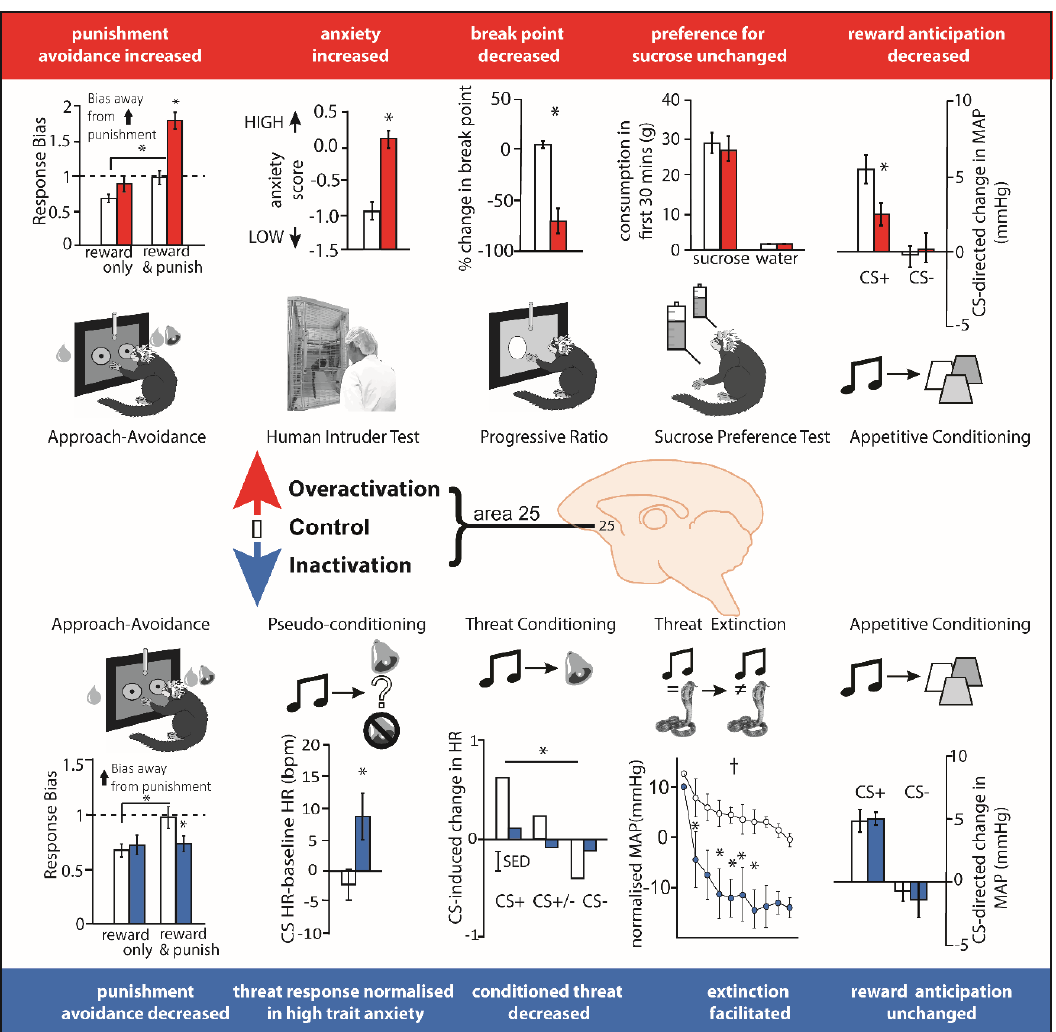
Figure 3. Over-activation and inactivation of area 25 in marmoset has largely opposing effects on tests measuring the regulation of responsivity to rewarding and punishing stimuli. Top from left. Over-activation via presynaptic glutamatergic disinhibition increased the bias away from punishment in an approach-avoidance decision making paradigm [140], and over-activation via inhibition of the excitatory glutamate amino acid transporter (EAAT2; with dihydrokainic acid [DHK]) increased anxiety-like behavior in the human intruder paradigm, increased the break point in a progressive ratio task, left sucrose consumption unaltered, and blunted the anticipation of food reward during appetitive conditioning [141]. Bottom from left. In contrast, inactivation with GABA A and B agonists (muscimol and baclofen) decreased the avoidance of punishment during approach-avoidance decision making [140] and reversed the blunted cardiovascular responsivity to threat in high trait anxious animals [46]. Inactivation also blunted the threat-induced anticipatory increases in heart rate and vigilant scanning (not shown) during Pavlovian threat conditioning and enhanced the rate of threat extinction [38], but had no e ff ect on reward anticipation during appetitive conditioning [141]. *, p < 0.05, † , p < 0.05, main e ff ect of manipulation; error bars indicate SEM. Thus, in general, over-activation blunted appetitive responses whilst enhancing threat-induced responses whilst inactivation primarily dampened threat-induced